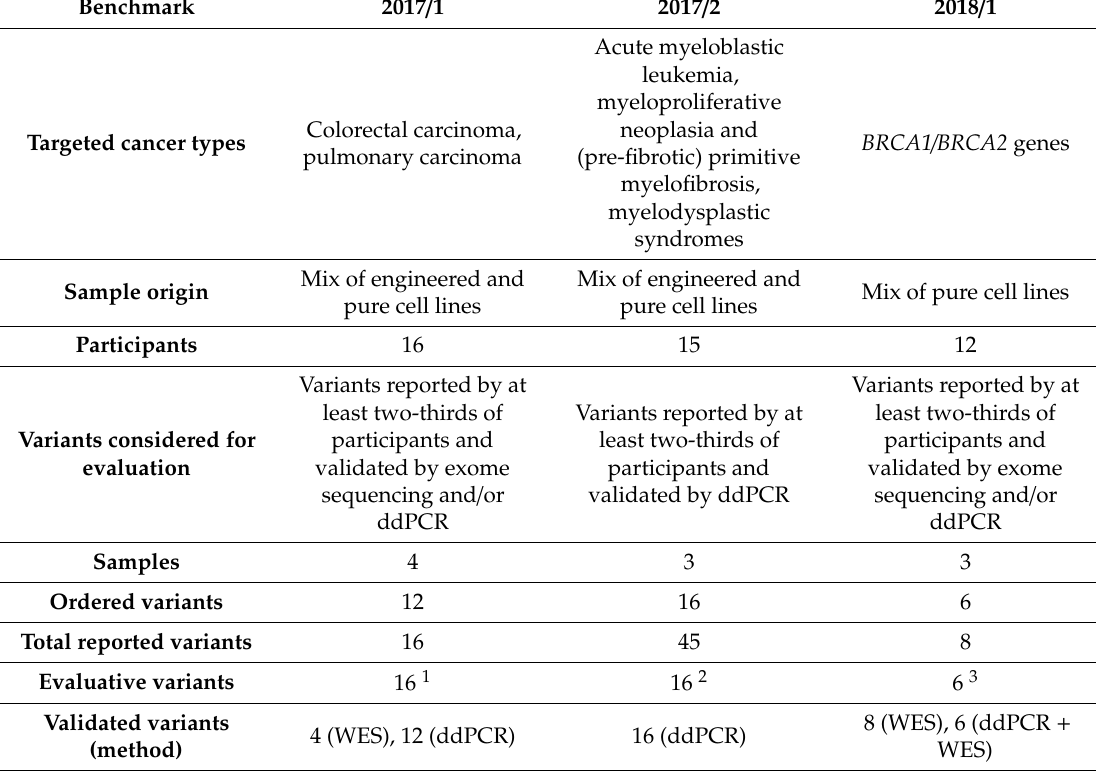
Table 1. General overview of benchmarks